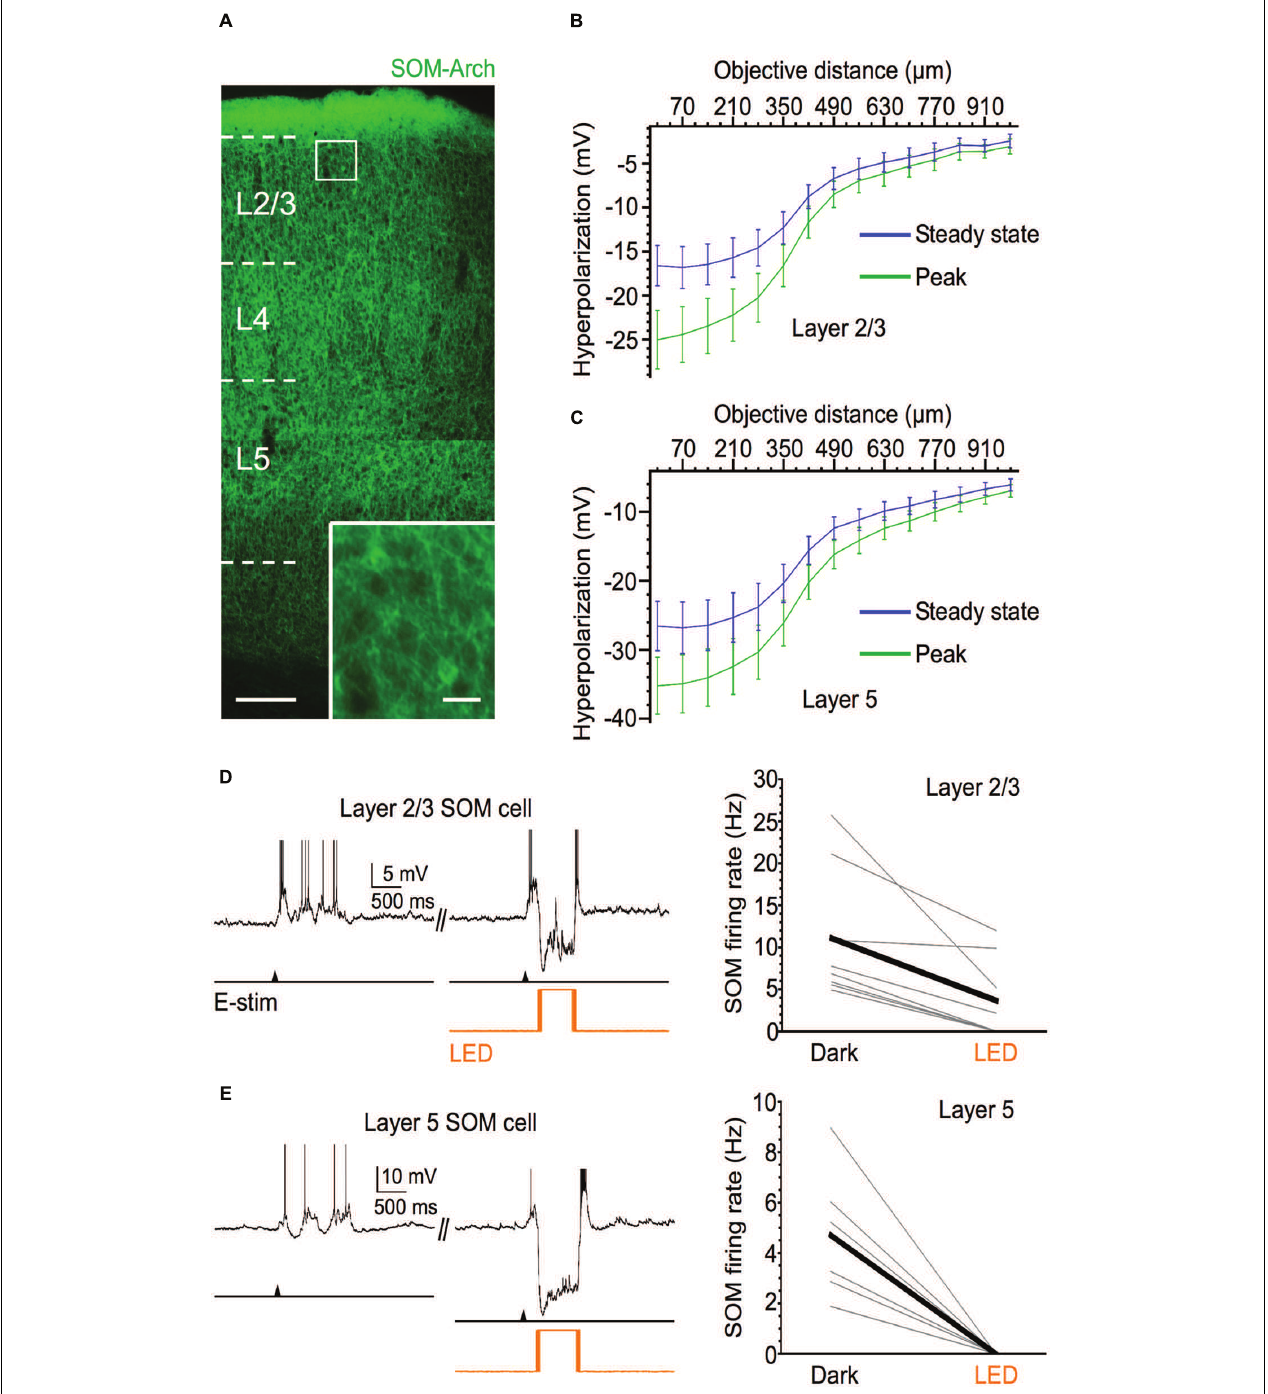
FIGURE 1 | Efficacy of Arch expression in SOM cells. (A) Fluorescent image of Arch-EYFP-expressing SOM cells throughout barrel cortex; scale bar = 200 µ m. Inset: expanded view of 2 Arch-expressing SOM cells, scale bar = 20 µ m. (B) Light-evoked hyperpolarization (500 ms pulse duration) of Arch-expressing SOM cells in layer 5 as 40x immersion objective is moved away from the recorded cell in 70 µ m increments ( n = 6 cells). Values plotted on green curve are peak values of hyperpolarization and values plotted on blue curve are steady-state values of hyperpolarization (measured during 50-ms period before offset of light stimulus). (C) As in (B) , but for Arch-expressing SOM cells in layer 2/3 ( n = 6 cells). (D) Light stimuli significantly decrease spiking output of layer 2/3 Arch-expressing SOM cells during evoked Up states. Example voltage trace is shown above. Shown below are population data ( n = 8 cells; Dark: 11.1 ± 2.8 Hz, LED: 3.6 ± 1.7 Hz, P = 0.014, paired t -test). (E) Light stimuli completely silence Up state spiking in all recorded layer 5 Arch-expressing SOM cells. Example voltage trace is shown above. Shown below are population data ( n = 6 cells; Dark: 4.7 ± 1.1 Hz, LED: 0 Hz, P = 0.007, paired t -test). Action potentials are truncated in (D,E) .